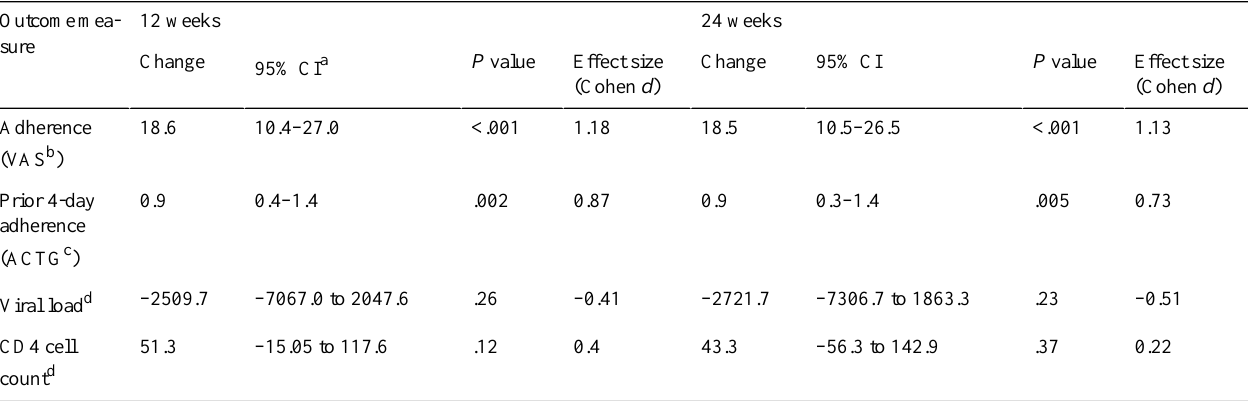
Table 3. Effect sizes and changes in adherence and biomarker outcomes from baseline to 12 and 24 weeks (n = 21 of 25).